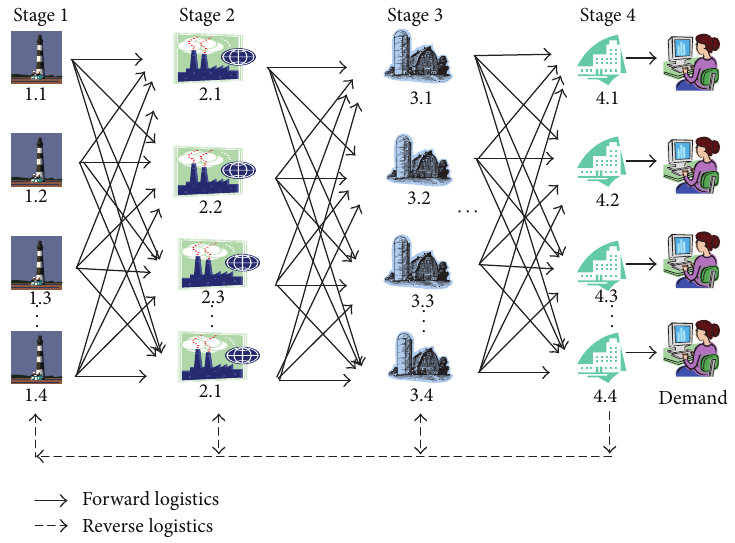
Figure 2: The transportation model of reverse